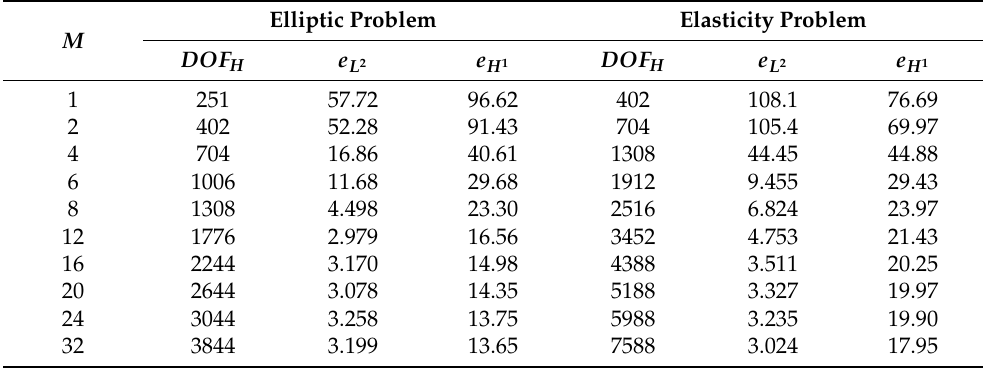
Table 7. Elliptic and elasticity problem with heterogeneous coefficients. Case 2 (non-homogeneous boundary conditions). Relative L 2 and H 1 error in